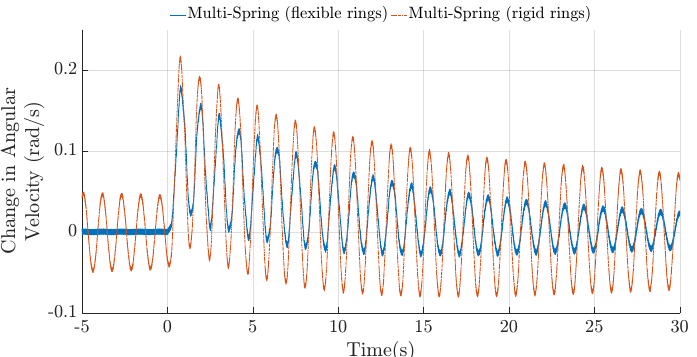
Figure 14. Results from the multi − spring representation comparing rigid and flexible carbon fibre rings within the